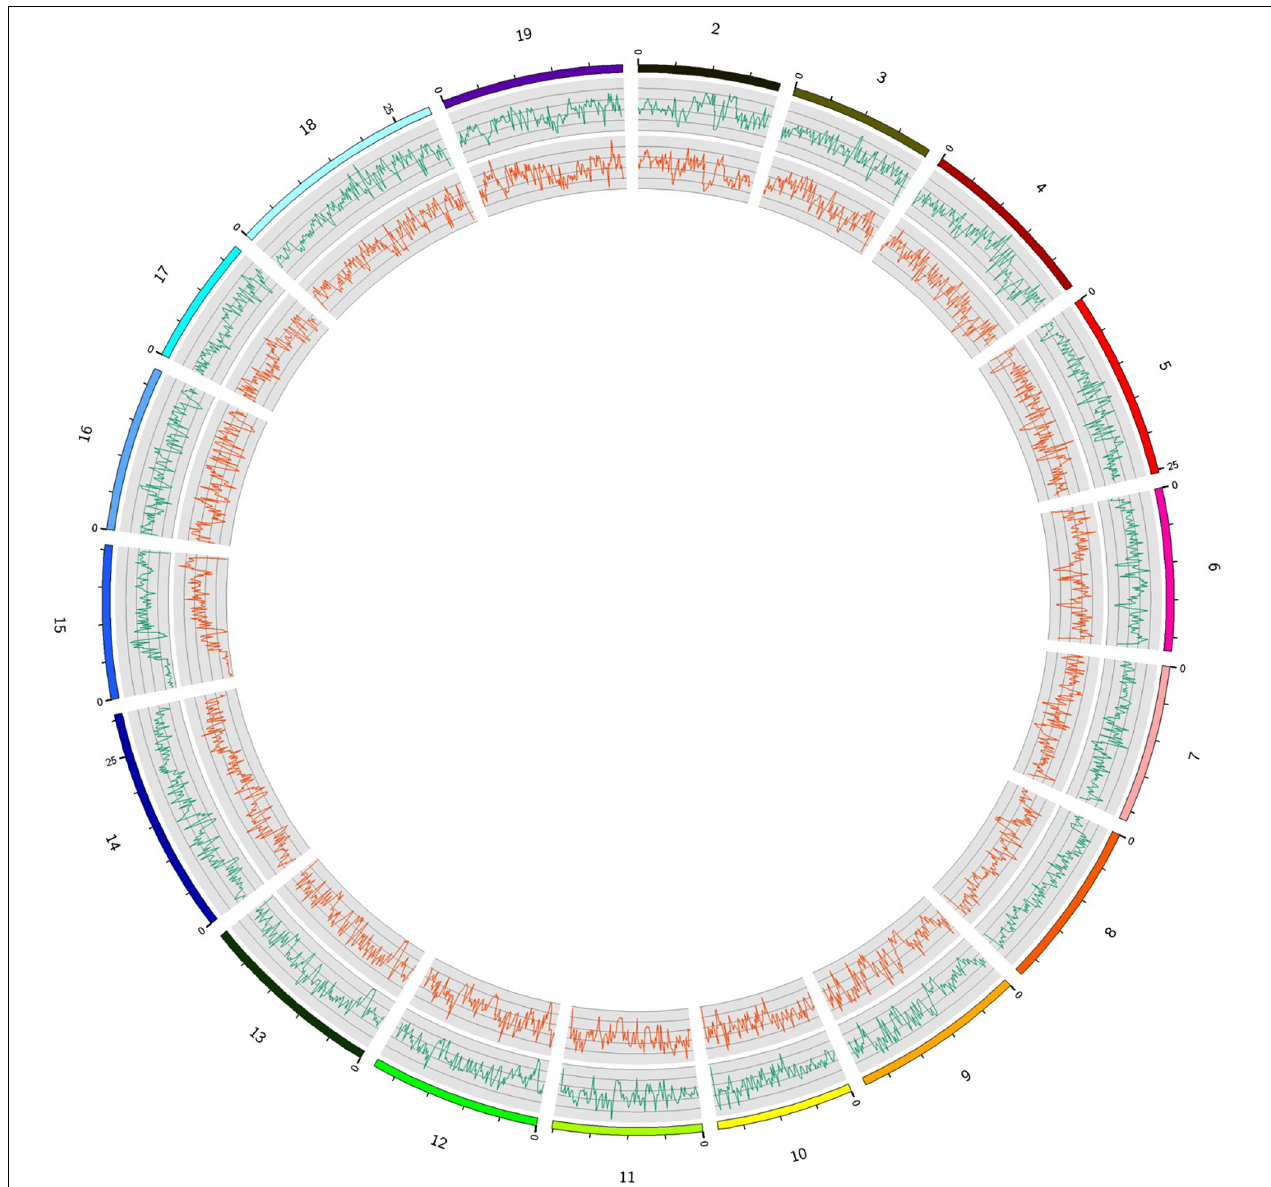
FIGURE 2 | Distribution of SNPs and InDels detected in the Munake cultivar and the reference genome of V. vinifera L. in the 19 chromosomes (outside, green lines = number of SNPs; inside, red lines = InDels).